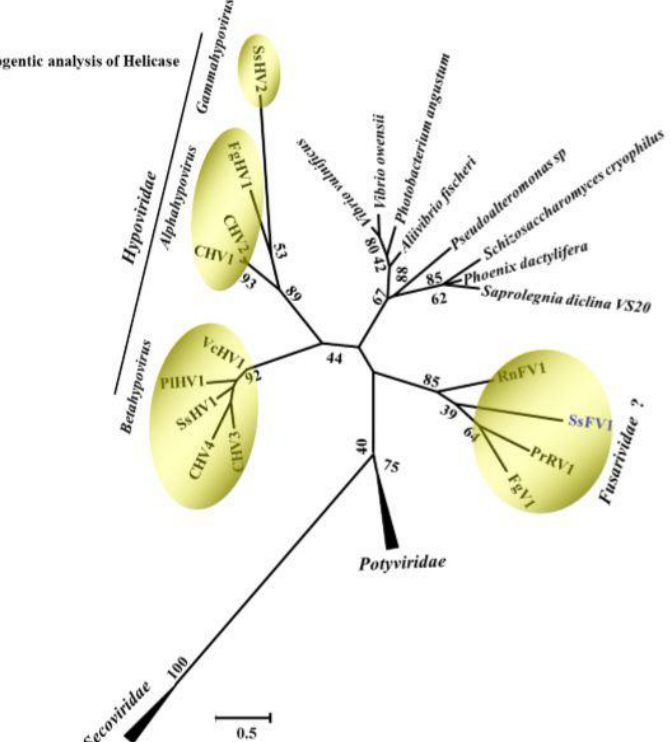
Figure 3. Multiple alignment and phylogenetic analysis of the conserved domains in SsFV1 and several selected viruses. ( a ) Multiple alignment of the aa sequences of the putative RdRp domains of SsFV1, FgV1, RnFV1, PrRV1, CHV3, and CHV4. The default color scheme for percentage identity in the Jalview program was used. Consensus is the consensus level for